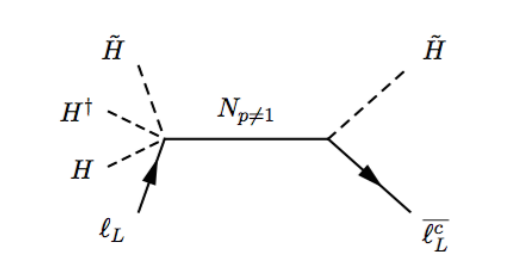
Figure 3 . Tree level exchange corresponding to the time ordered product T ( L 6 ( x ) ; L 4 ( y )) gener- ating a perturbation to the neutrino mass